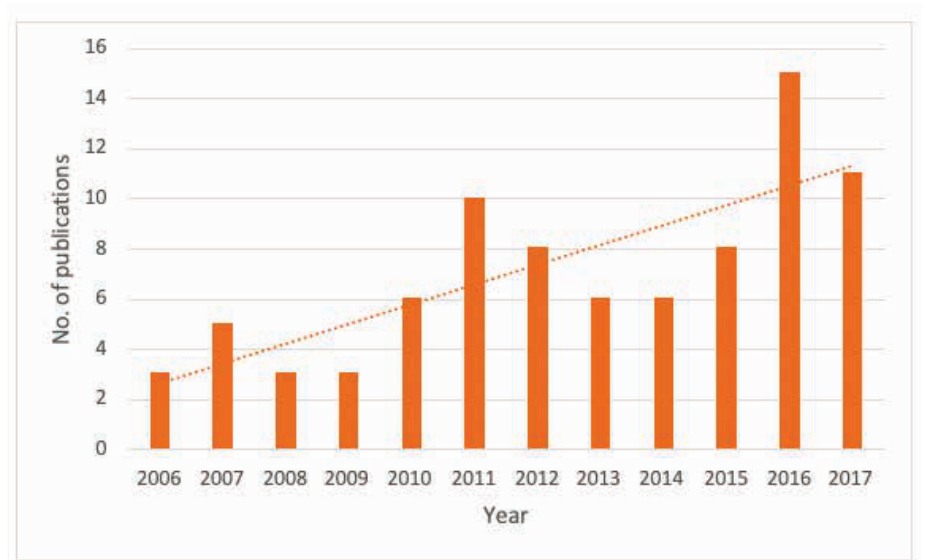
Figure 1: Temporal development and trend of the number of peer-reviewed publications on biodynamic food and farming in the scientific literature